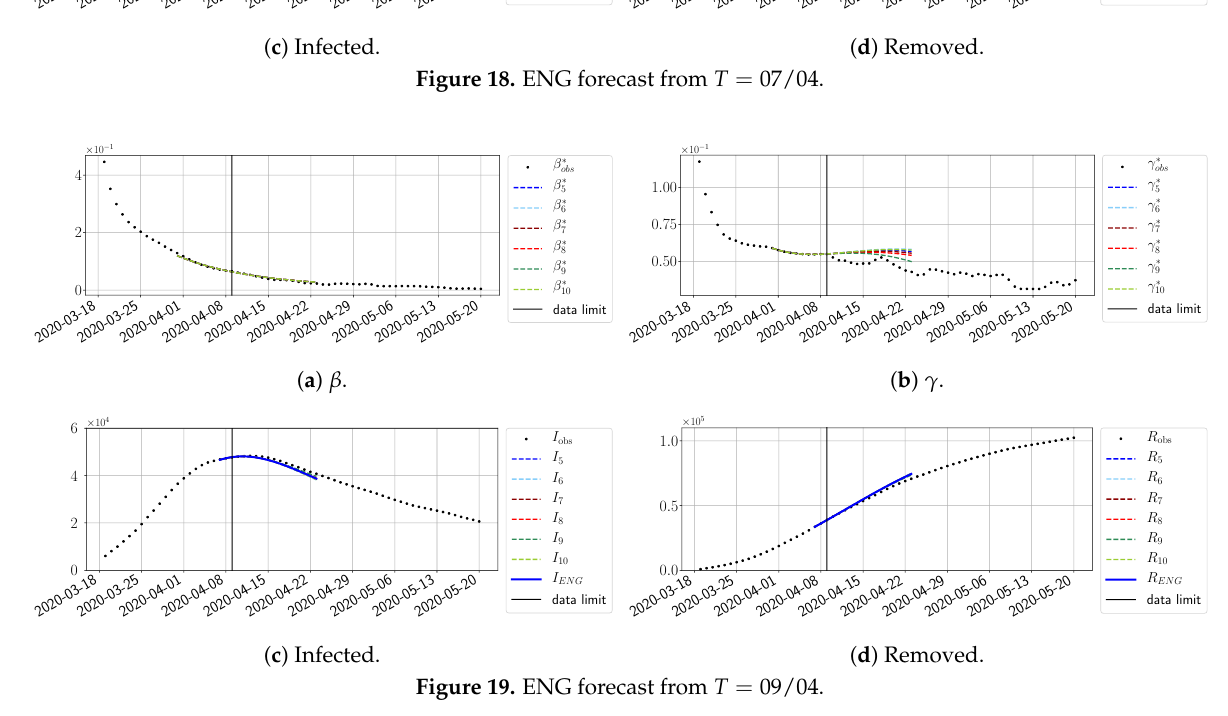
Figure 18. ENG forecast from T = 07/04.